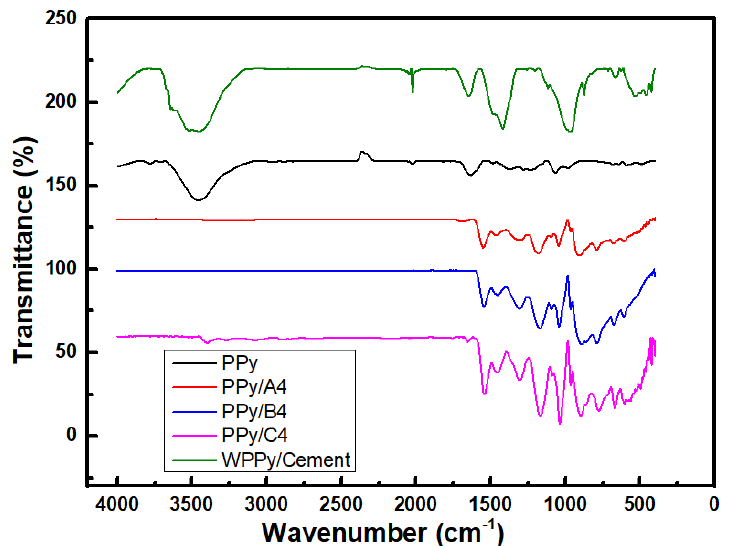
Figure 3. FTIR spectra of PPy, PPy/A4, PPy/B4, PPy/C4, and WPPy/cement composite.